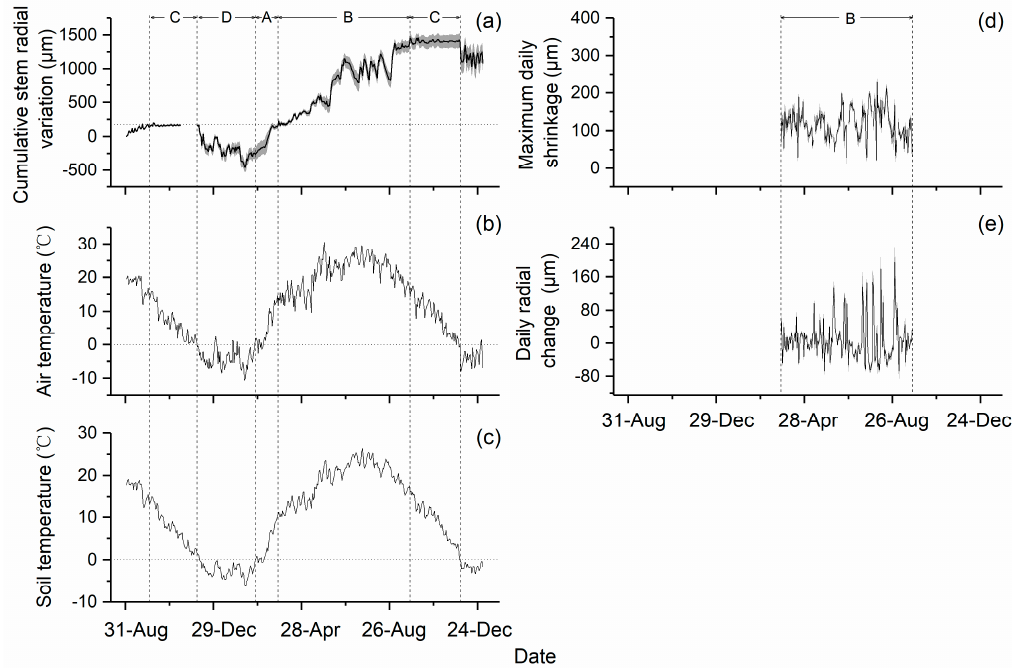
Figure 5. Daily time series of cumulative stem radial variation (CRV) ( a ), air temperature ( b ), soil temperature ( c ), maximum daily shrinkage (MDS) ( d ), and daily radial change (DRC) ( e ); the four distinct growth periods of P. orientalis radial change corresponding to spring rehydration (phase A), the summer growing season (phase B), autumn stagnation (phase C), and winter contraction (phase D). The standard errors for CRV, MDS, and DRC are indicated by the shaded areas around the black lines.